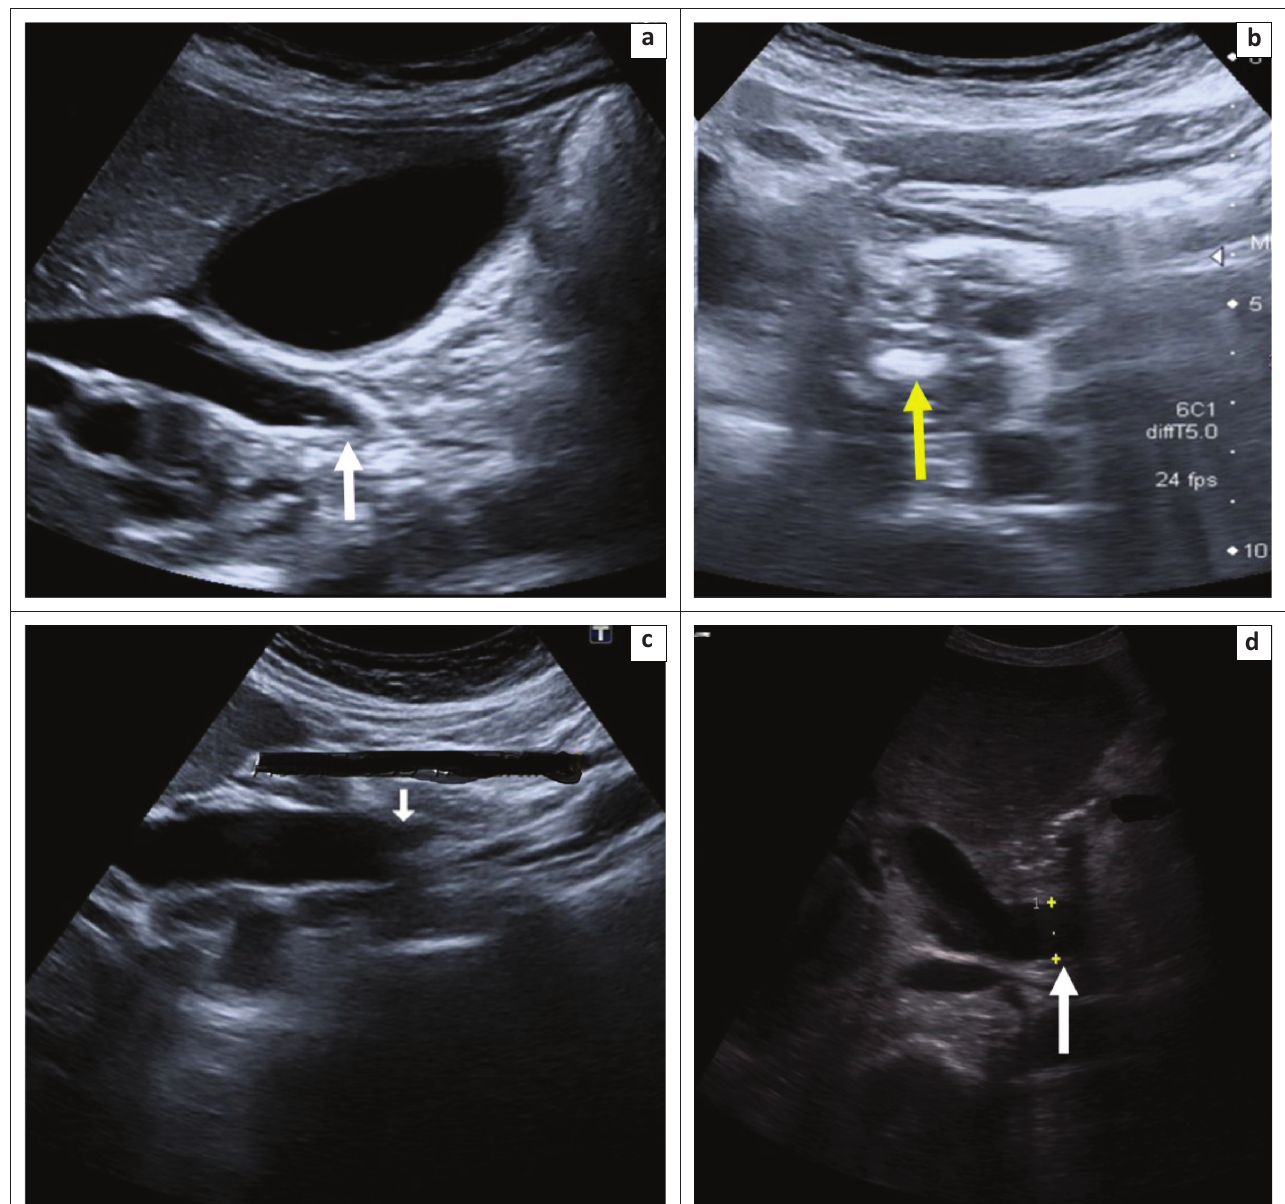
FIGURE 2: Examples illustrating the differences in the appearance of the transition zone in some study patients: (a) Smooth tapering of a benign stricture in the distal common bile duct (white arrow) in a patient with chronic pancreatitis; (b) coarse calcifications in the head of pancreas (yellow arrow) in the same patient; (c) and (d) abrupt cut-off of the common bile duct (white arrow) in two different patients with pancreatic head masses.